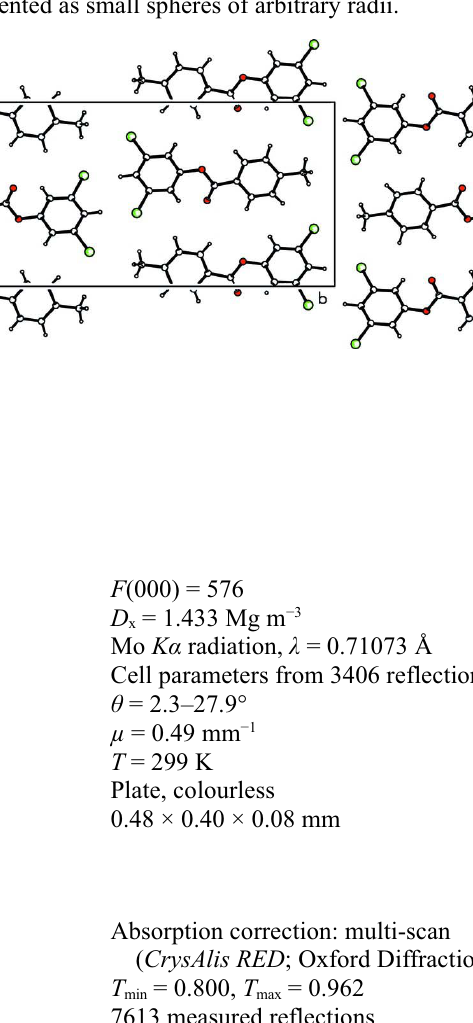
Molecular structure of the title compound, showing the atom labelling scheme. The Displacement ellipsoids are drawn at the 50% probability level. The H atoms are represented as small spheres of arbitrary radii.